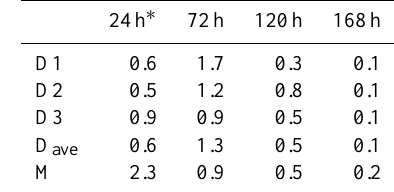
Fig. 8. Sensitivity study with respect to iron dissolution timescale. Solid: surface DFe using a timescale of 3 days; dashed: surface DFe using an instantaneous dissolution. Circles are measured surface DFe concentrations. Error bars show the total range of measured